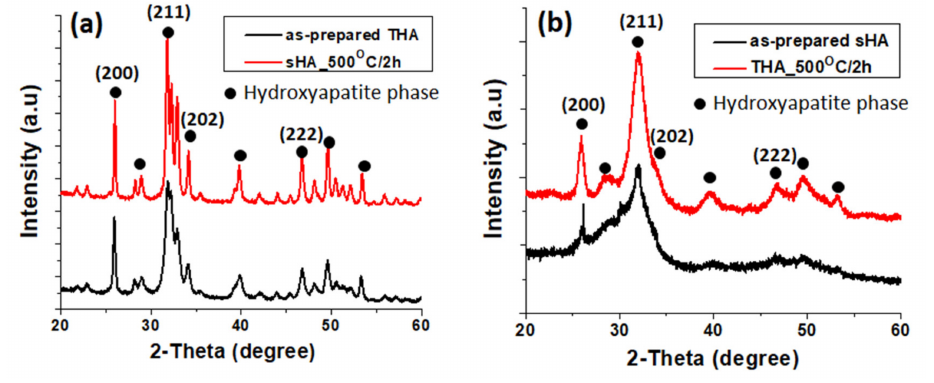
Figure 2. XRD patterns of sHA ( a ) and THA ( b )